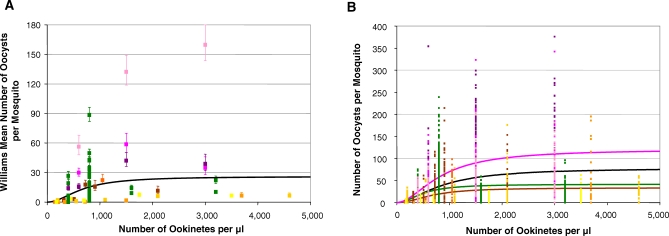
Analysis of Parasite Densities in the Transition from Ookinetes to Oocysts(A) WM number of oocysts per mosquito against number of ookinetes per μl of blood. Mean oocyst density is related to ookinete density by a sigmoid function. Error bars denote standard errors of the WMs.(B) Number of oocysts per individual mosquito against number of ookinetes per μl of blood. The black line is fitted to the combined data; the brown line to data from [88]; the green line to data from JM; and the pink line to data from experiments by JW. In all cases the fitted curve corresponds to a sigmoid function (with an underlying nonlinear, power relationship between overdispersion and mean oocyst density). Assuming a bloodmeal volume of 2.13 μl, ookinete density can be expressed per mosquito by multiplying by 2.13.All data pertain to P. berghei in An. stephensi. Markers refer to one experiment by JM (green), three by JW (pink/violet), and five by [88] (orange/yellow/brown).